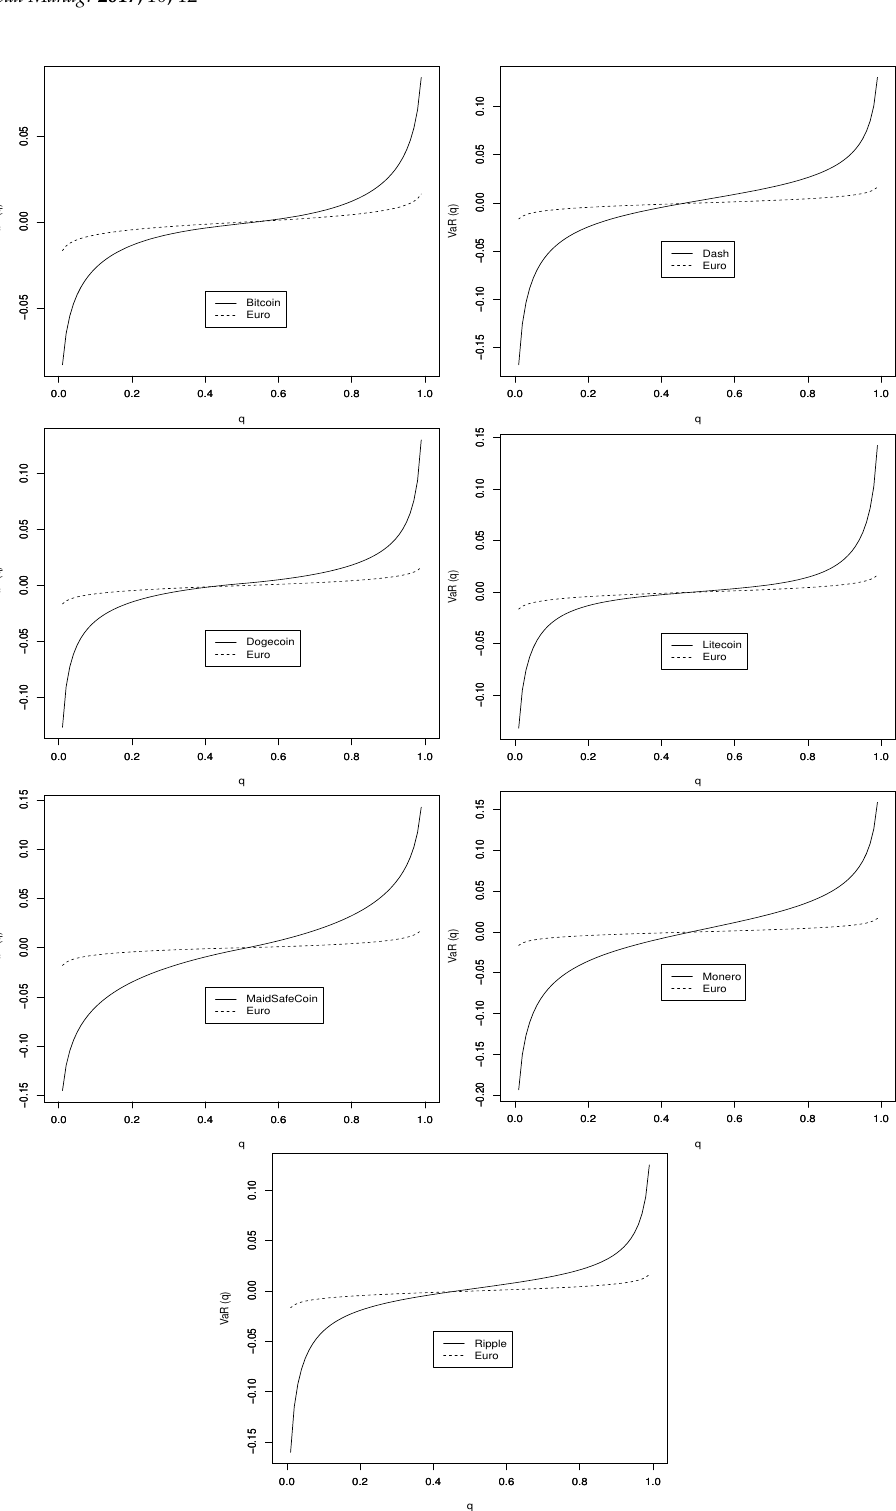
Figure 4. Value at risk for the best fitting distributions for daily log returns of the exchange rates of Bitcoin (first row, left), Dash (first row, right), Dogecoin (second row, left), Litecoin (second row, right), MaidSafeCoin (third row, left), Monero (third row, right) and Ripple (last row) from 23 June 2014 until 28 February 2017. Also shown are the values at risk for daily log returns of the exchange rates of the Euro computed using the same best fitting